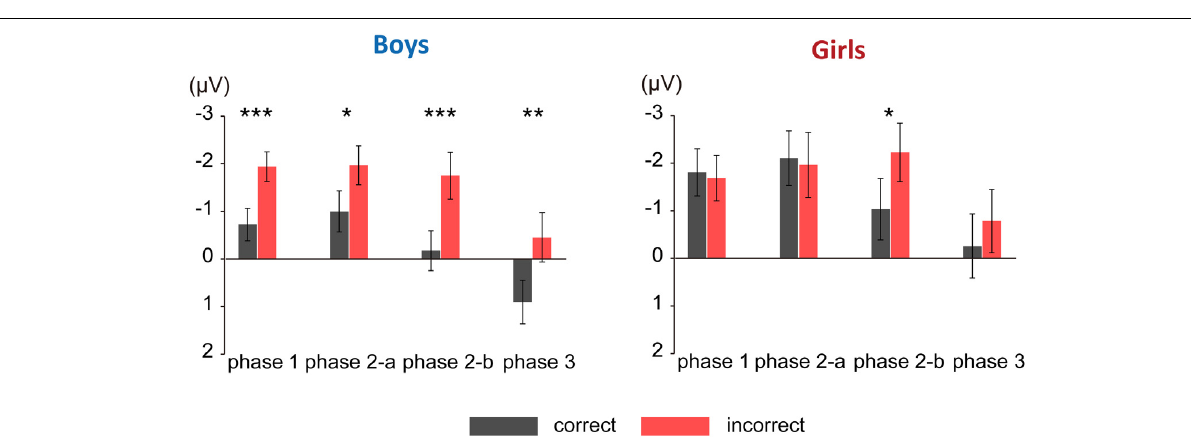
FIGURE 4 | Mean amplitude of each phase. The mean amplitudes of the five exploring electrodes are plotted for each phase. Left : mean amplitude for boys; right : mean amplitude for girls. Black bars denote amplitude for correct sentences. Red bars denote amplitude for incorrect sentences. Asterisks represent statistical significance in post hoc comparisons ( ∗∗∗ P < 0.005, ∗∗ P < 0.01, ∗ P < 0.05). Error bars indicate standard